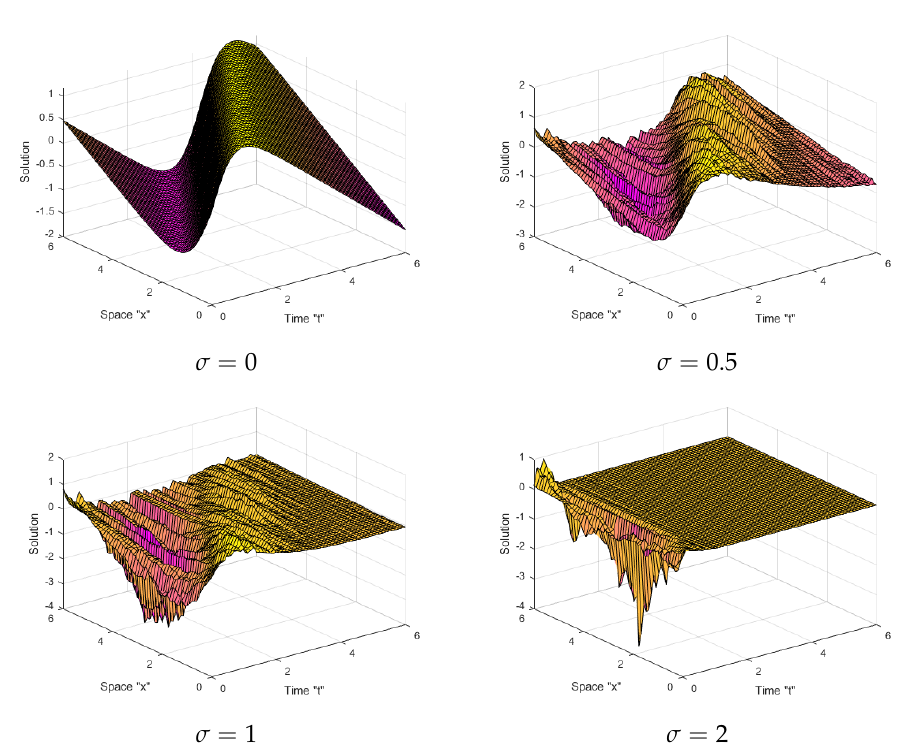
Figure 6. The 3D-profiles of solution Ψ ( x , t ) in Equation (19) for various values of σ